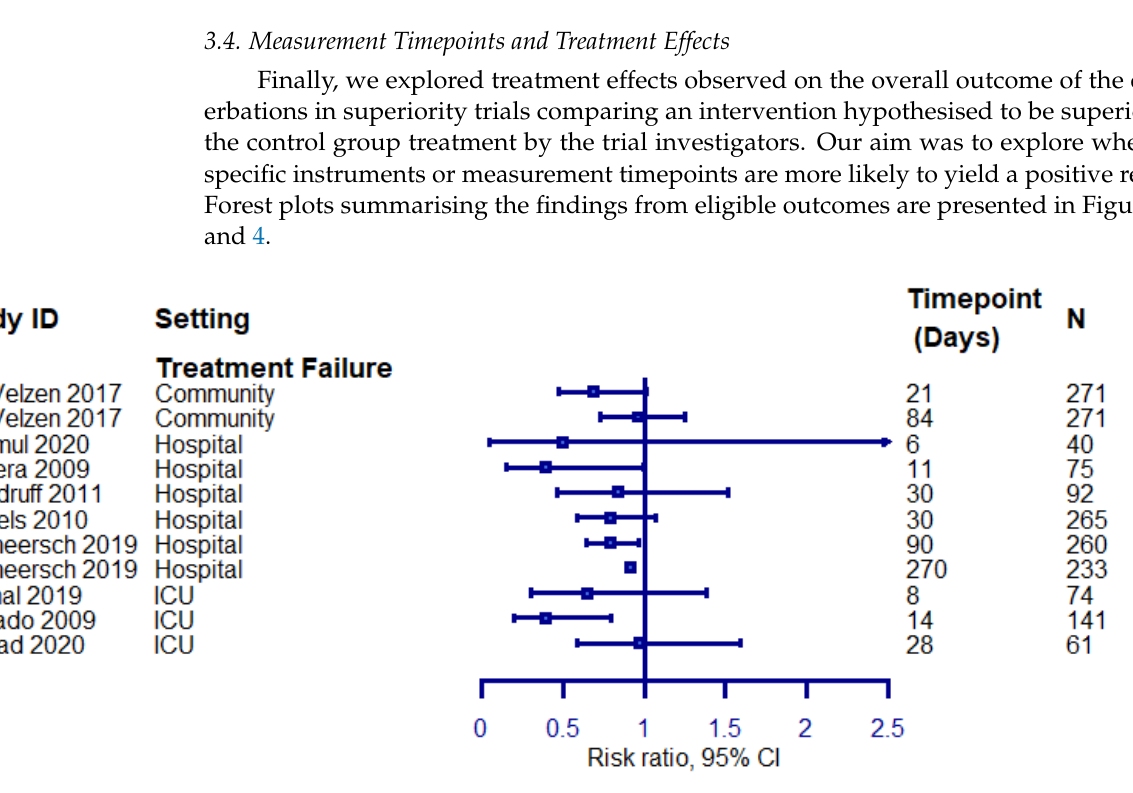
Figure 3. Treatment effects on treatment failure rates in superiority trials assessing treatment failure as a composite outcome. The left-hand side favours the intervention. N: study population.